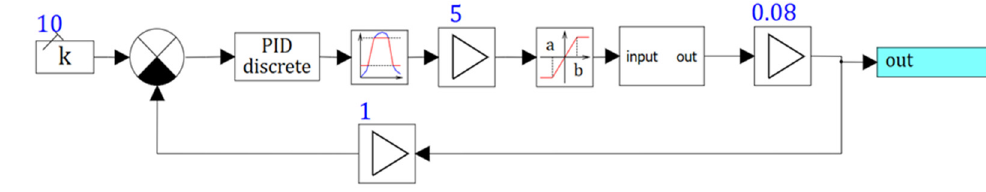
Figure 10. Transient plots in continuous and continuous-discrete actuator models. The results were compared with the classic PID controller for this motor. After opti- mization, the transient time was reduced from 0.9 s. to 0.8 s.